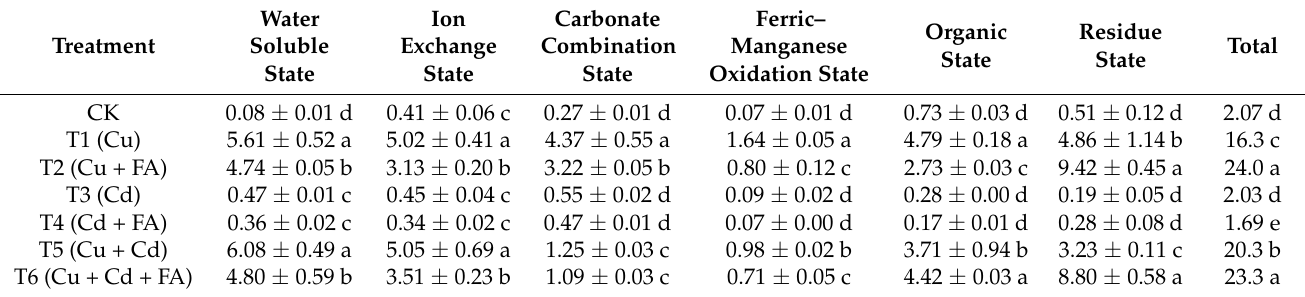
Table 4. The contents of different Cu forms in topsoil under different Cu, Cd treatments (mg · kg − 1 ).